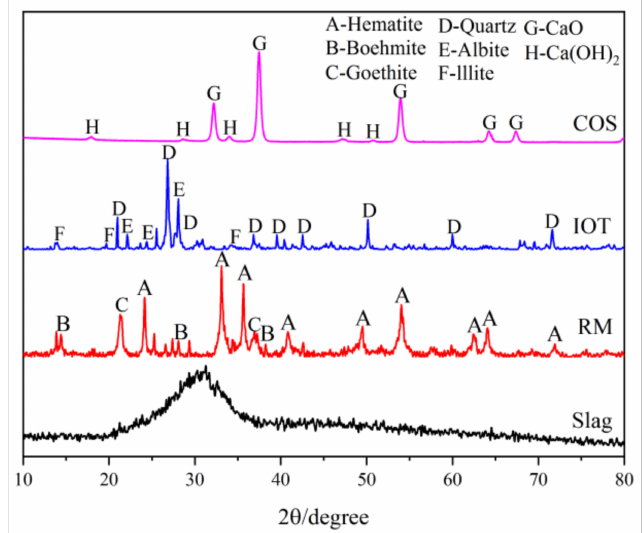
Figure 2. XRD of raw materials (hematite: PDF 01-089-0597; boehmite: PDF 01-072-0359; goethite: PDF 01-081-0464; quartz: PDF 00-046-1045; albite: PDF 00-009-0466; illite: PDF 01-070-3754; CaO: PDF 01-078-0649; and Ca(OH) 2 : PDF 00-004-0733).